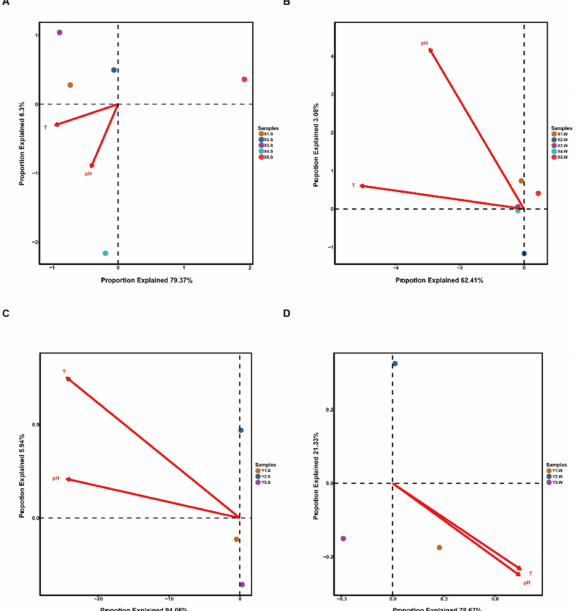
Figure 6. Redundancy analysis (RDA) ordination biplot for environmental factors and microbial communities. ( A ) X stream sediment samples, ( B ) water samples, ( C ) Y stream sediment samples, ( D ) water samples. T is the